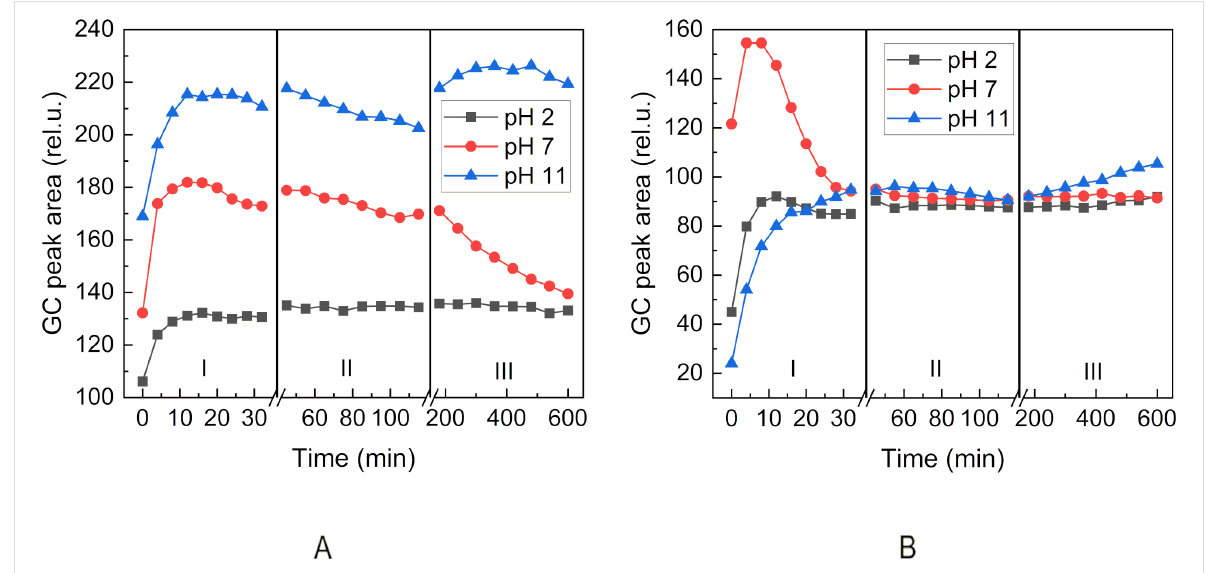
Figure 6: Time evolution of the headspace concentration of benzaldehyde ( 2d ) after successive extractions from the gaseous phase above (A): benzaldehyde ( 2d ) in aqueous phosphate buffers and (B): benzylimino- β -CD ( 3d ) in aqueous phosphate buffers. Sampling intervals in the corre- sponding regions: I – 4 min, II – 10 min, III – 60 min.